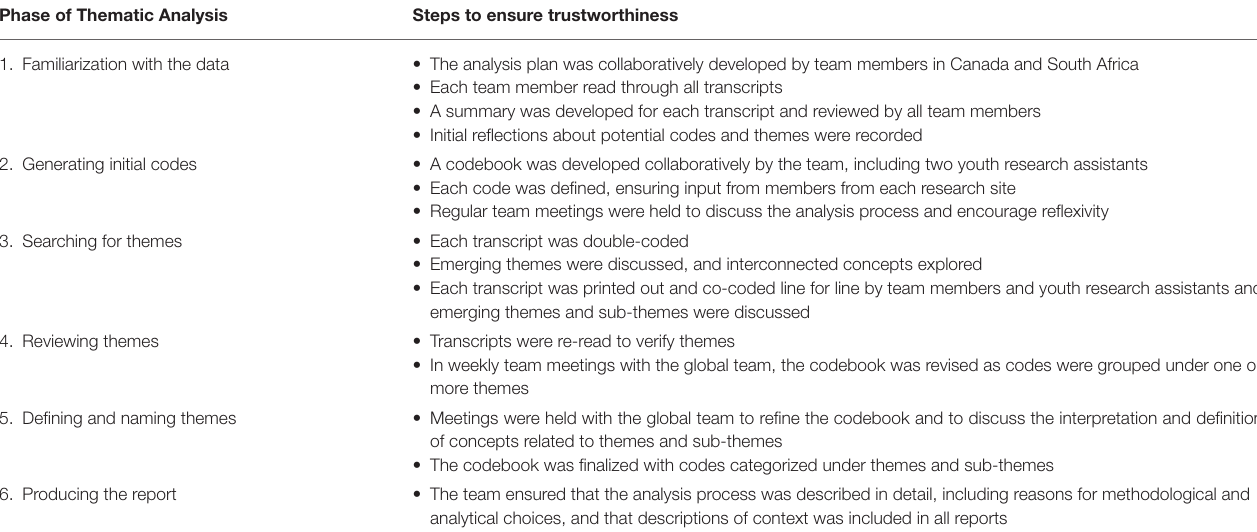
TABLE 1 | Ensuring trustworthiness through a collaborative, youth-engaged thematic analysis